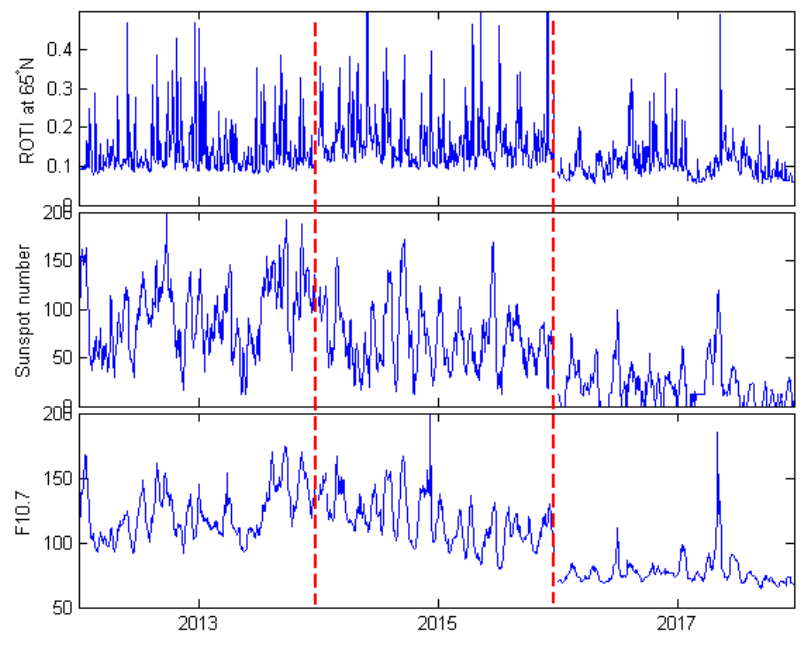
Figure 3. Average high-latitude ROTI comparison with the solar indices (sunspot number R and F10.7